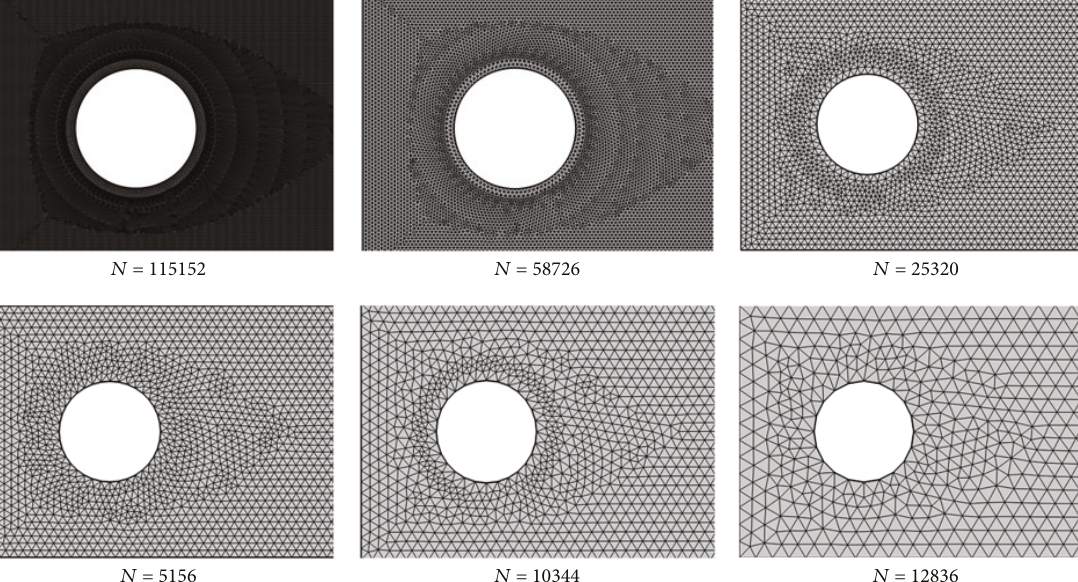
Figure 2: Finite element meshes near the heated cylinder with different configurations.